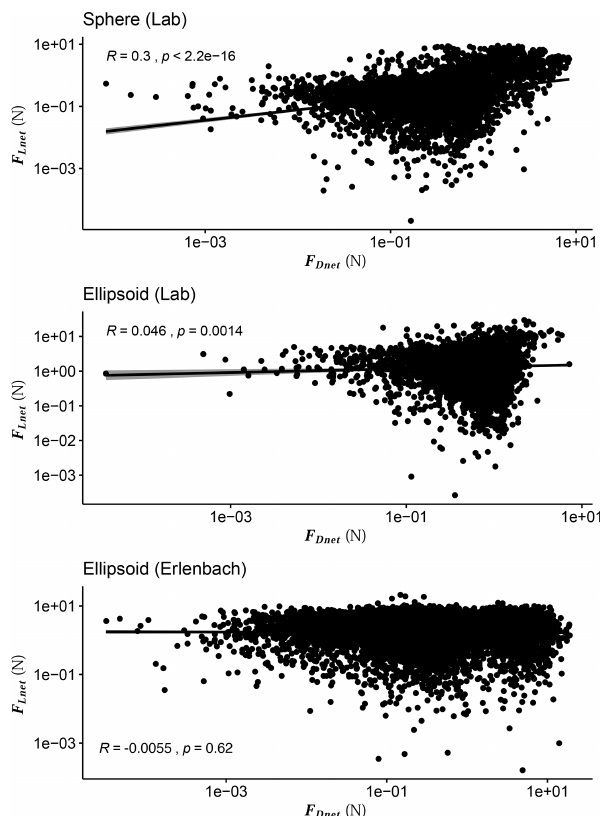
Figure E2. Lift vs. drag force magnitude correlation (flume experiments). Regression analysis applied to the magnitude of calculated forces (drag and lift) shows a moderate correlation for the spherical particle (statistically significant Pearson’s R = 0 . 3) and a weak correlation for the ellipsoid in both the laboratory and the field experiments – statistically significant Pearson’s R = 0 . 046 for the lab measurements, ellipsoid (Lab), and insignificant Pearson’s R = − 0 . 00055 for the field ones, ellipsoid (Erlenbach). The latter supports the assumption of statistical independence between the two components for the ellipsoid, justifying the randomisation presented in Sect. 5 (Fig. 7). Pearson’s R is an unbiased metric for this sample